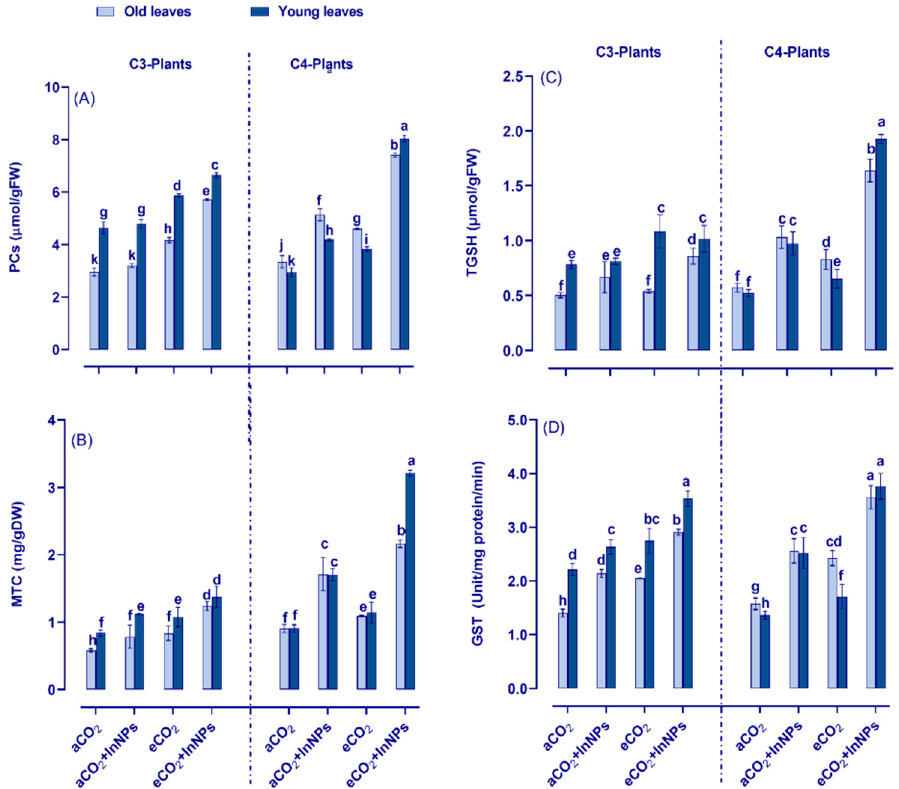
Figure 4. Effect of In 2 O 3 -NPs either alone or in combination with eCO 2 upon ( A ) phytochelatins (PCs); ( B ) metallothionein (MTC); ( C ) total glutathione (TGSH); ( D ) glutathione transferase (GST) of both old and young leaves of C3 and C4 plants. Four biological replicates are used to demonstrate each value. The vertical error bar represents the standard error (SE). Fisher’s LSD test ( p < 0.05; n = 4) was used to compare the data for each response separately. Different letters indicate significant differences between means in the young and old leaves of C3 or C4 plants.